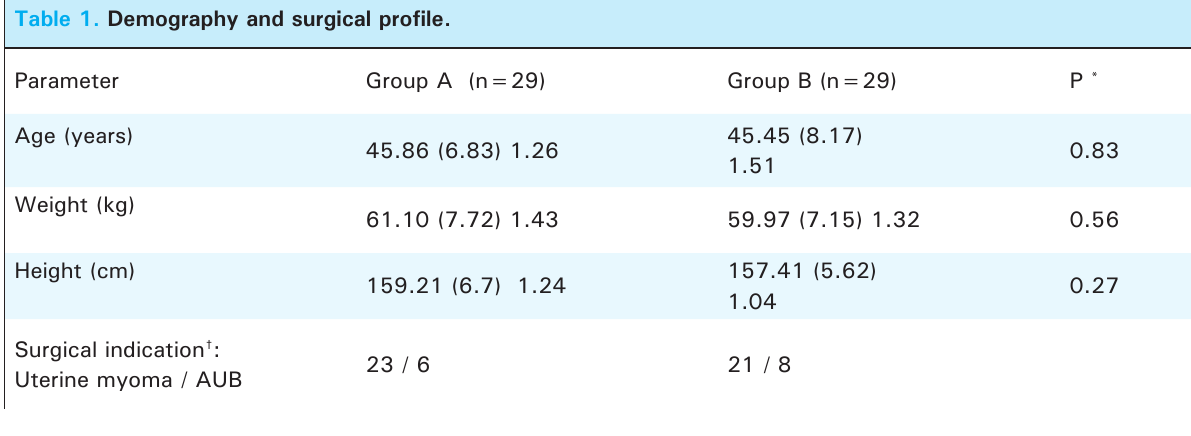
Free Full Text Articles are Available at www.jnma.com.np